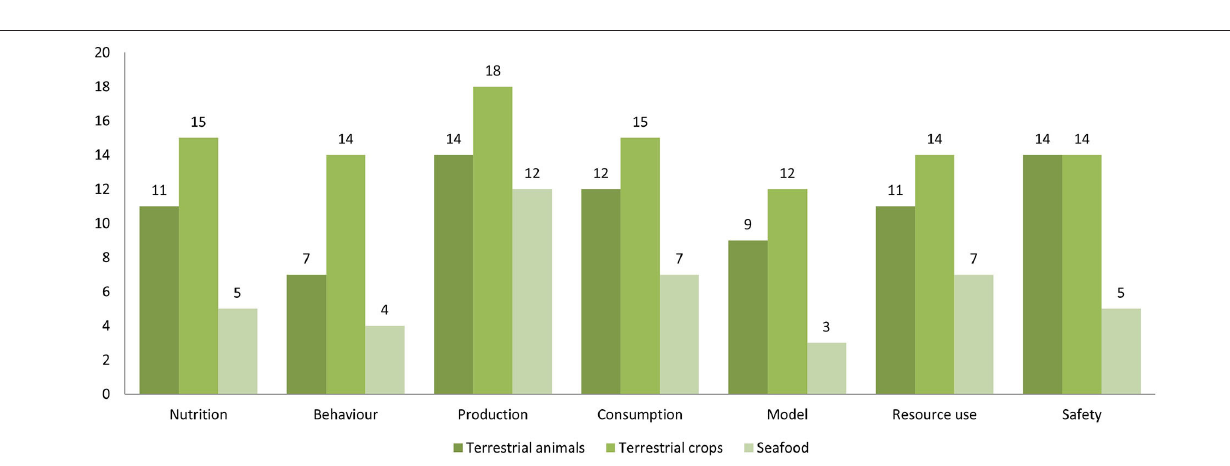
Frontiers in Sustainable Food Systems |